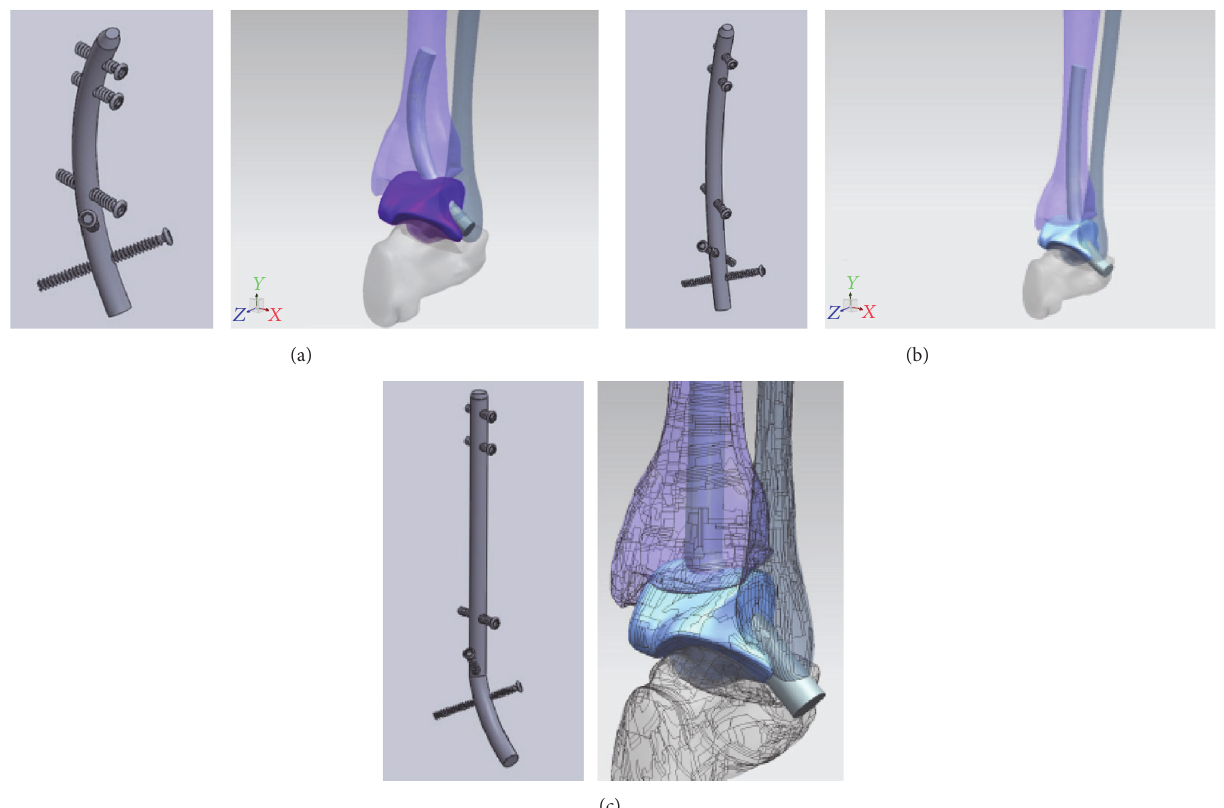
Figure 5: Constant curve nail with 1 curve (CC1), constant curve nail with 2 independent curves (CC2), and straight with bent straight end nail (SBSE).